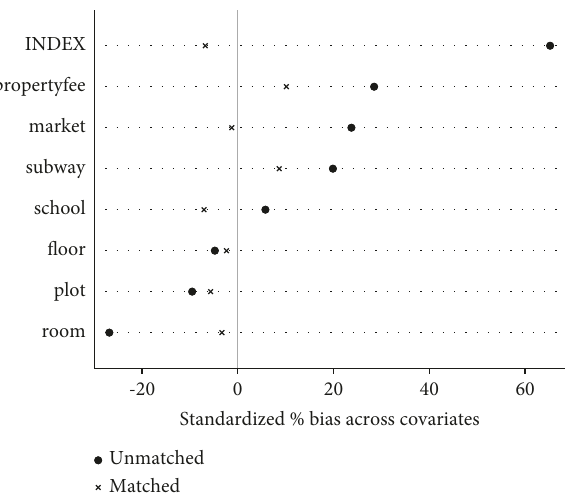
Figure 2: Standard deviation before and after matching the experimental and control groups (%).